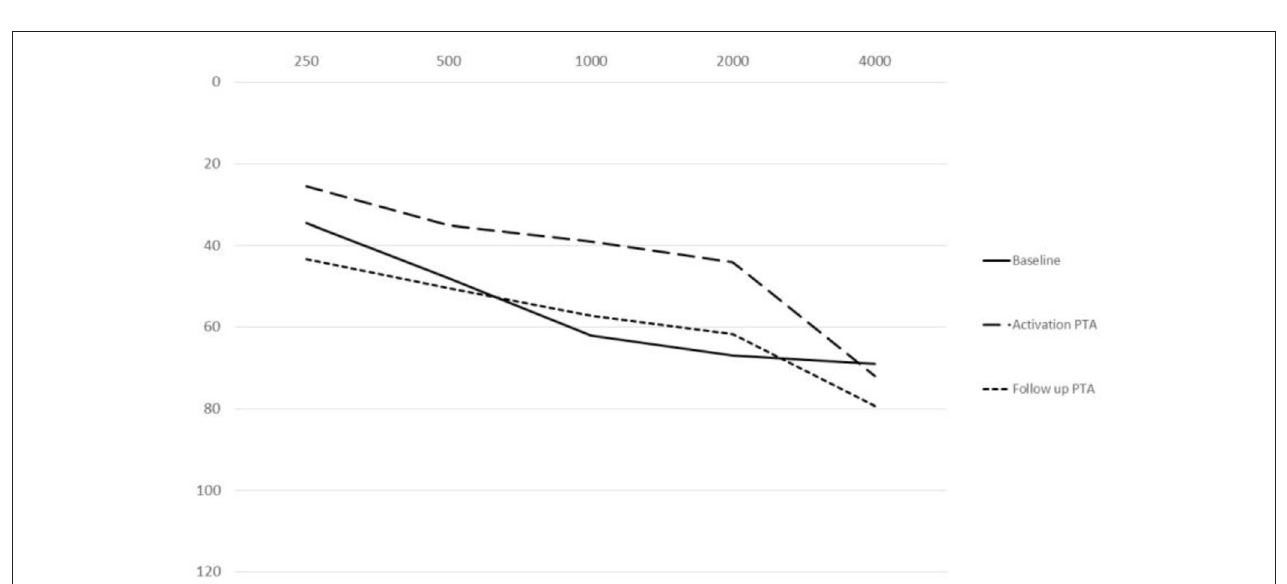
FIGURE 5 | Comparison among PTA threshold values at baseline, activation and